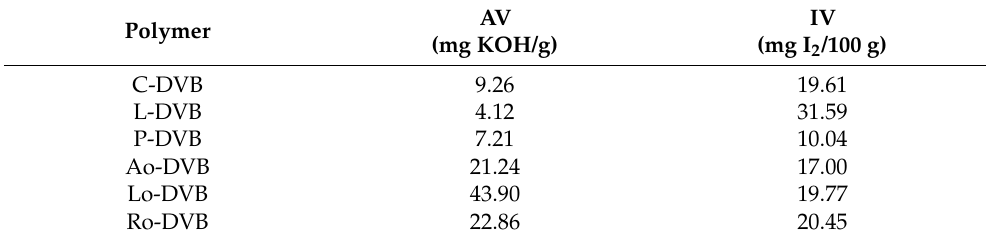
Table 3. Characteristic chemical parameters: acid values (AV) and iodine values